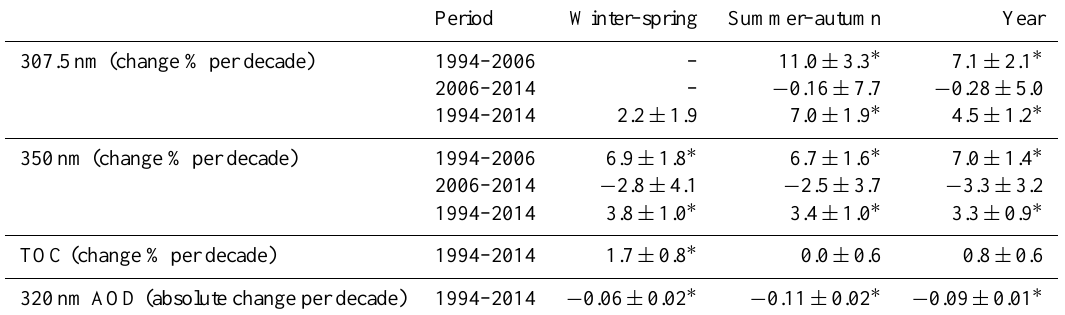
Table 1. Trends of TOC, AOD at 320nm and spectral UV irradiance at 307.5 and 350nm, for different periods. Asterisks denote the statistically significant